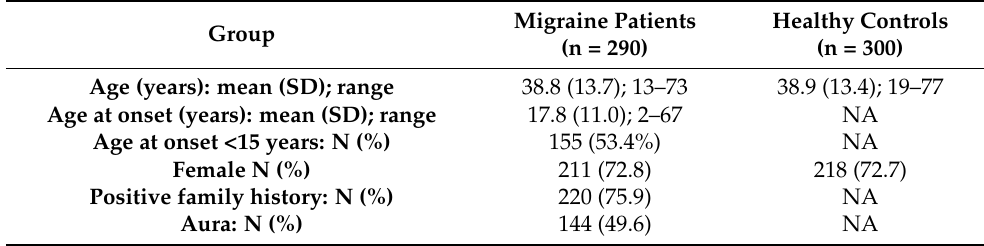
Table 3. Demographic and clinical data of the series studied.